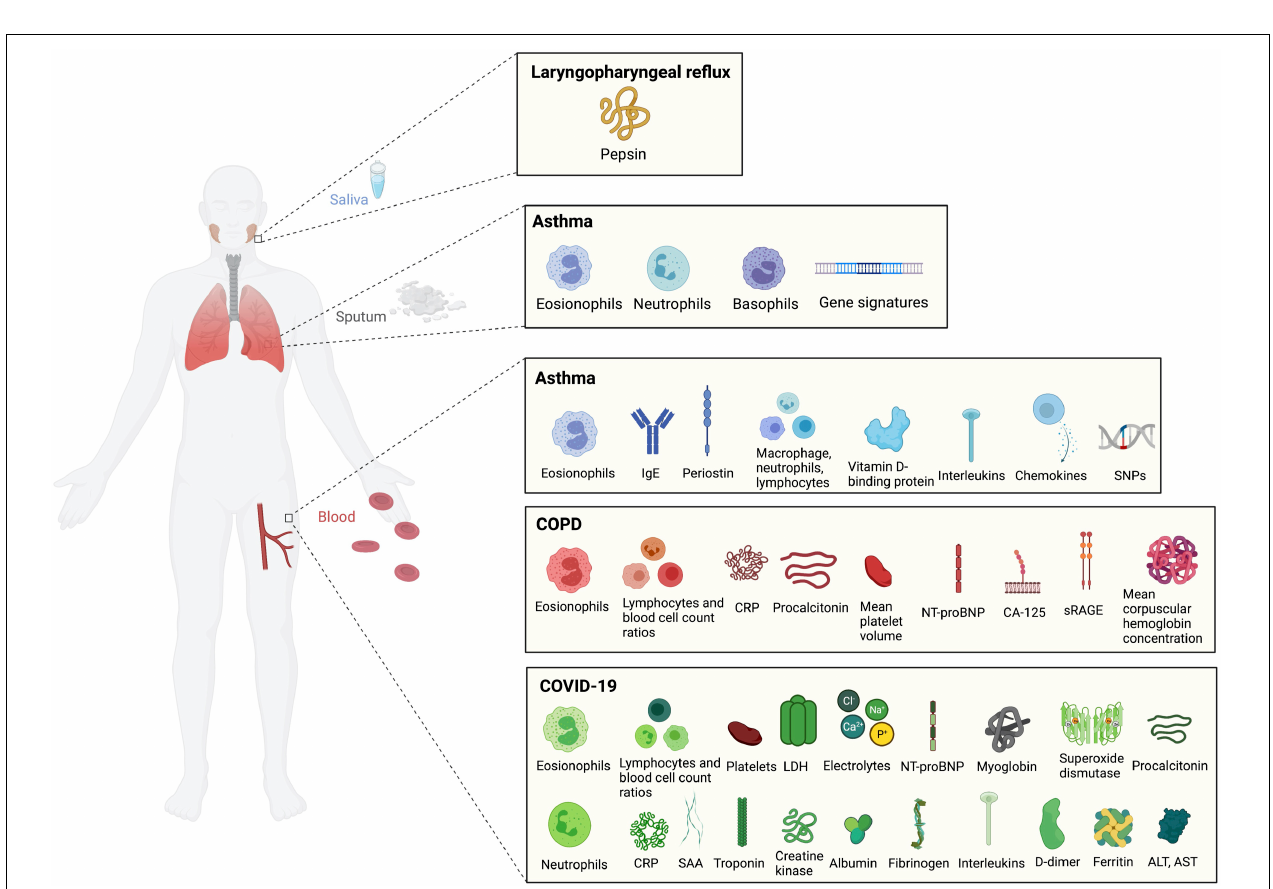
FIGURE 2 | Liquid biomarkers of airway